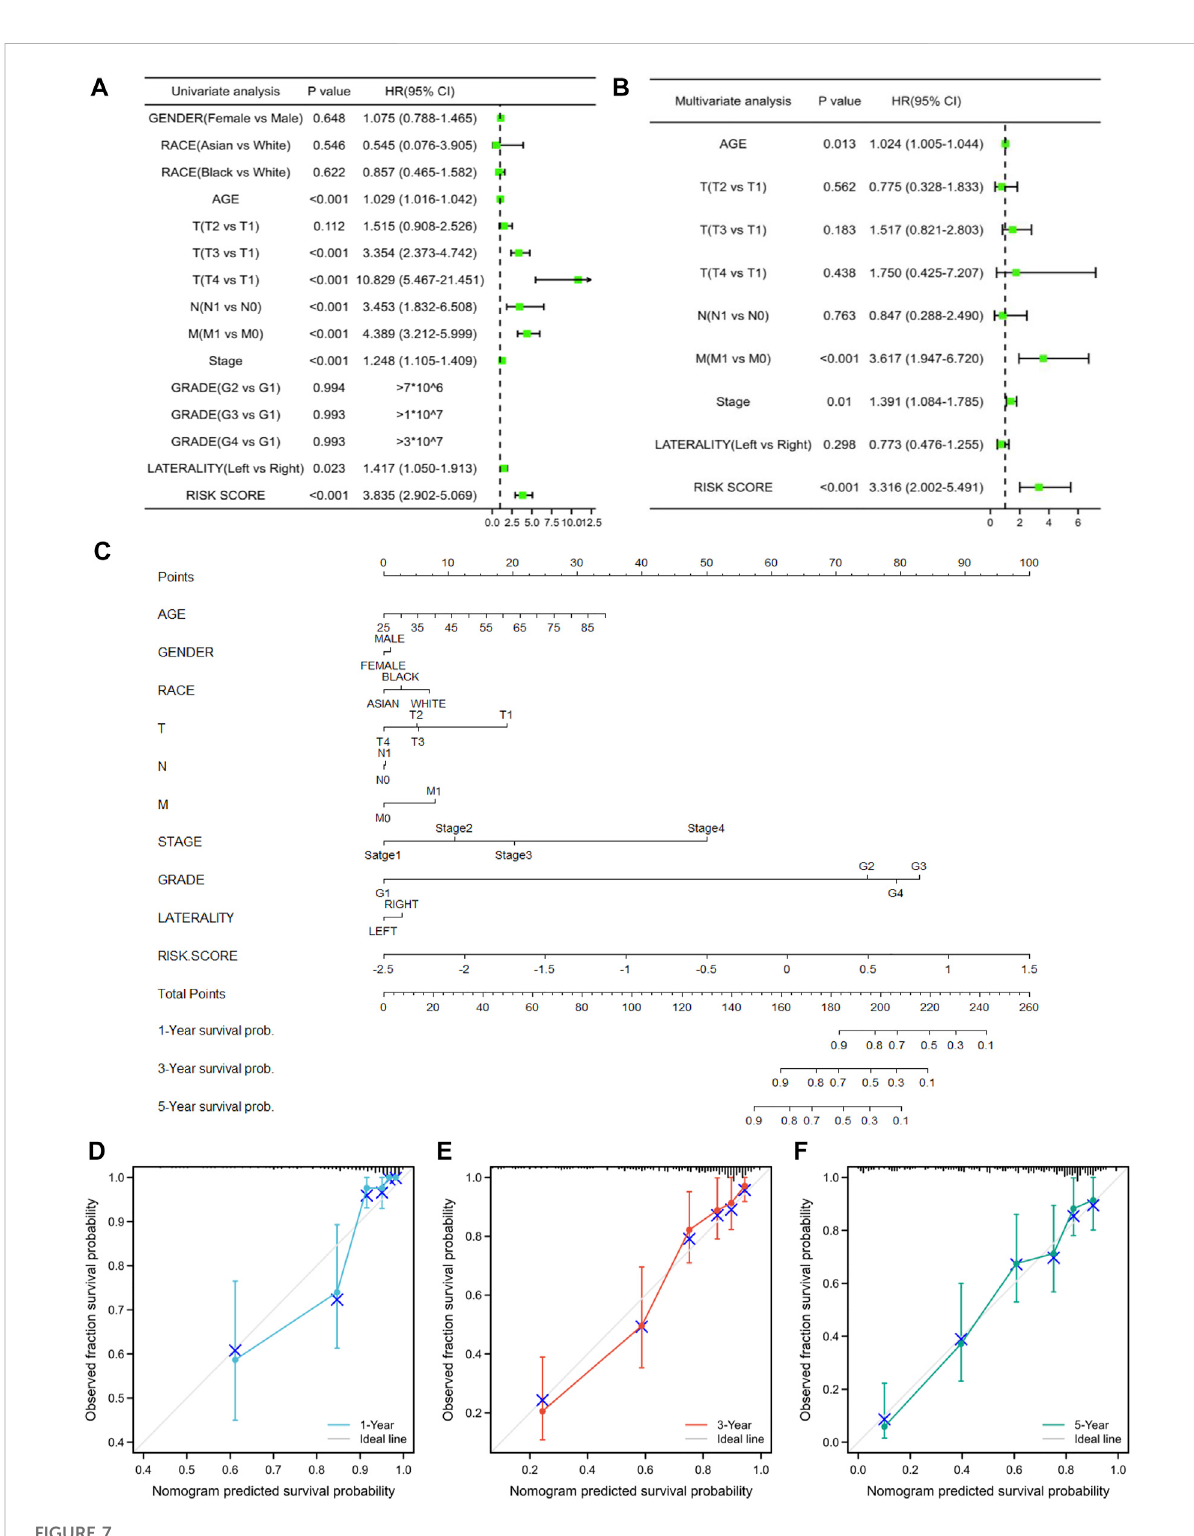
FIGURE 7 Independent prognostic value and clinical utility of the prognostic model. (A,B) Univariate and multivariate Cox regression analyses for investigating the association of the ER stress-related gene model and conventional clinical factors with KIRC prognosis. (C) Prognostic nomogram basedon theERstress-related model forprediction of1-,3-, and5-year survival rates. (D – F) Calibration plots ofthenomogram at1-, 3-, and5-year